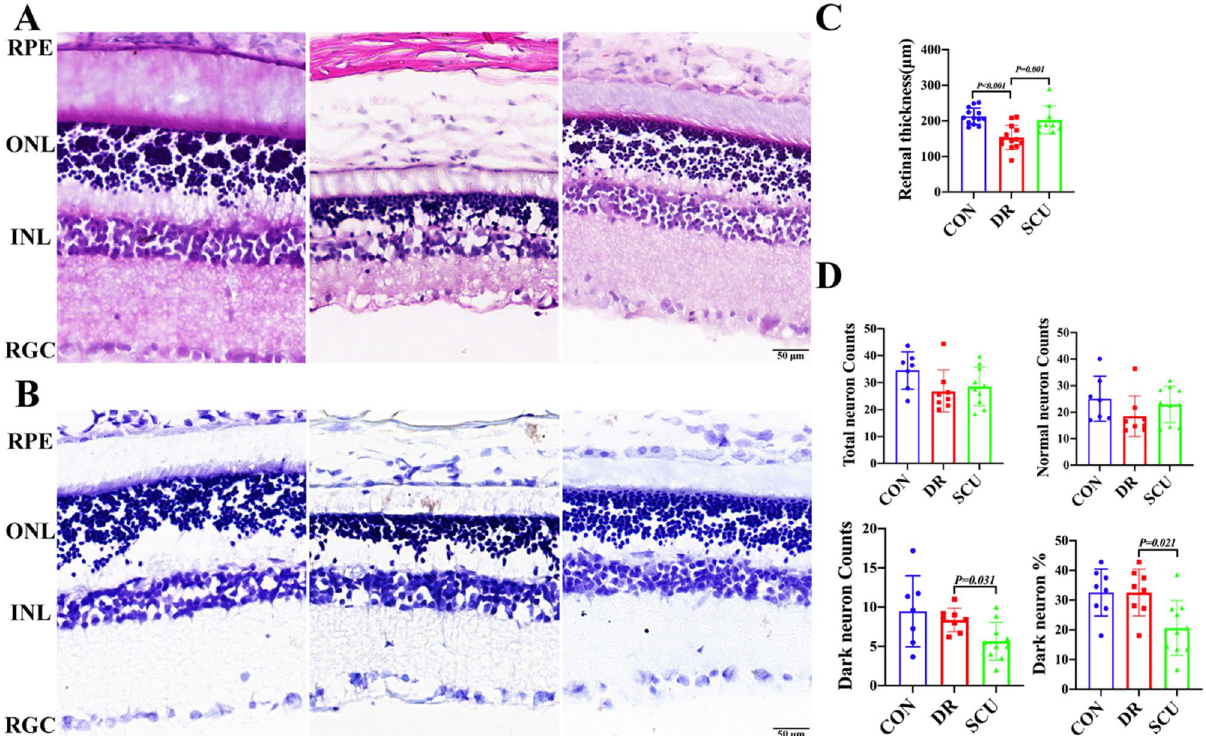
Figure 1. HE staining and Nissl Staining of retinal tissue in rats with diabetic retinopathy treated by SCU. ( A ) HE staining: Control group, diabetic retinopathy group, and SCU treatment group. Bar = 50 μm, RPE retinal pigment epithelial cells, ONL outer nuclear layer, INL inner core layer, RGC retinal ganglion cells. ( B ) Nissl staining: Control group, diabetic retinopathy group, and SCU treatment group. Bar = 50 μm, RPE retinal pigment epithelial cells, ONL outer nuclear layer, INL inner core layer, RGC retinal ganglion cells. ( C ) Comparison of retinal thickness between Control group, diabetic retinopathy group and SCU group. ( D ) Total retinal neurons, apoptotic neurons, percentage of apoptotic neurons and normal neurons were quantified in Control group, diabetic retinopathy group and SCU